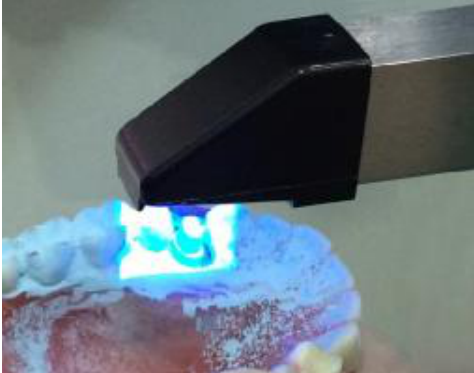
Figure 3: Scanning with Bluecam camera.